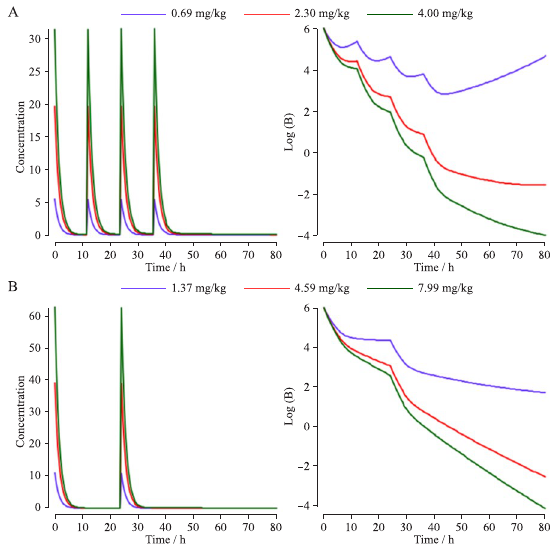
Fig. 5 Predicted growth of APP under different regimens: per 12 h ( A ), per 24 h ( B